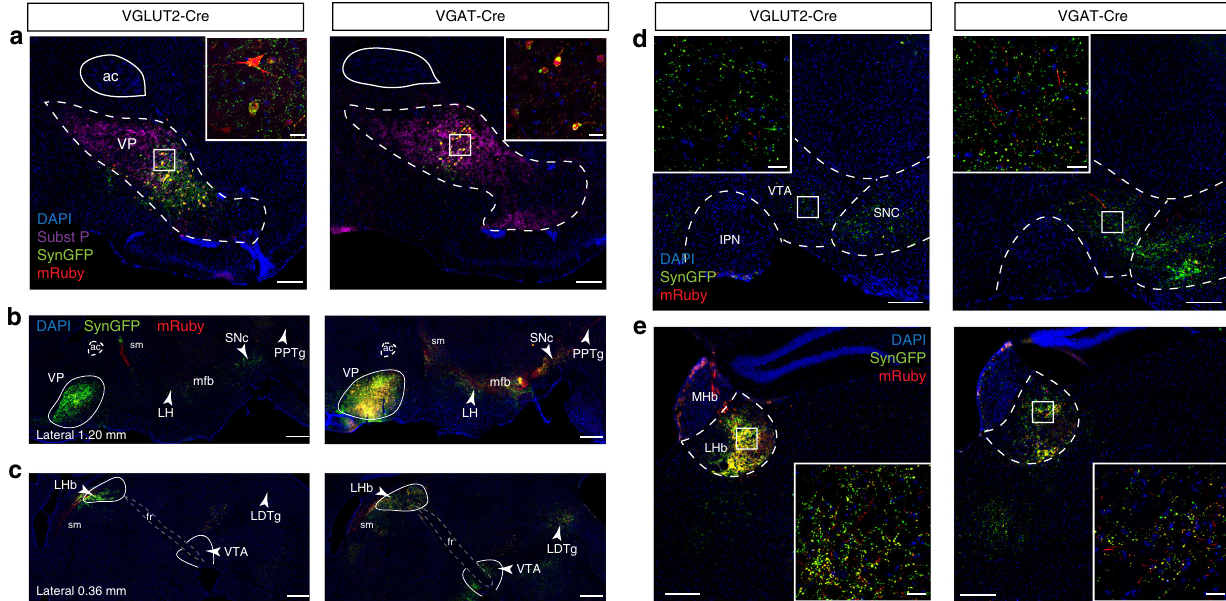
Fig. 2 Projections of VP glutamate and GABA neurons. a Coronal section showing expression of cytosolic mRuby and Synaptophysin:GFP in VP glutamate and GABA neurons using VGLUT2-Cre or VGAT-Cre mouse lines. b – c Sagittal sections showing VP glutamate and GABA neurons project to similar targets throughout the brain including lateral hypothalamus (LH), ventral tegmental area (VTA), substantia nigra pars compacta (SNc), lateral habenula (LHb), pedunculopontine nucleus (PPTg), and laterodorsal tegmental nucleus (LDTg) as seen in sagittal sections from two different lateral coordinates. The anterior commissure (ac) and fasciculus retro fl exus (fr) — habenulointerpeduncular tract — are highlighted with dashed lines. Approximate borders of the VP, LHb, and VTA are delineated with plain white lines. Coronal sections through two key VP afferents in the d . VTA and e . LHb. IPN interpeduncular nucleus, MHb medial habenula, ac anterior commissure, sm stria medullaris, mfb medial forebrain bundle, fr fasciculus retro fl exus. Scale = 200 µ m (wide fi eld), and 20 µ m (insets). See also Supplementary Figures 2, 3, and